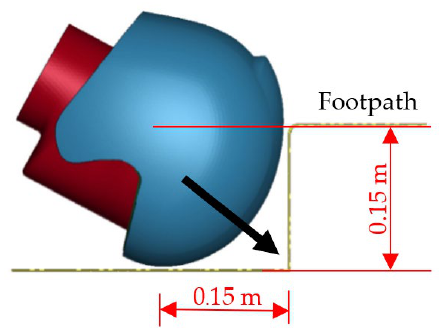
Figure 13. FE model for collision with a footpath.